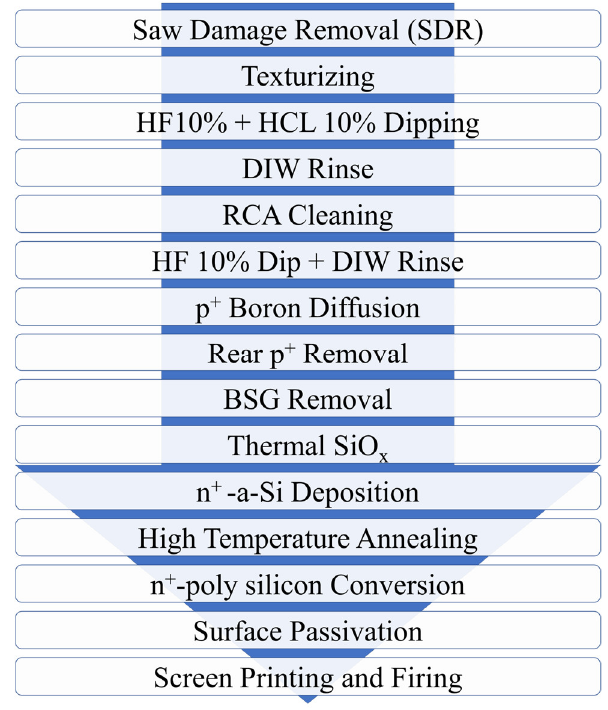
Figure 5. TOPCon solar cell fabricating process chart [33].